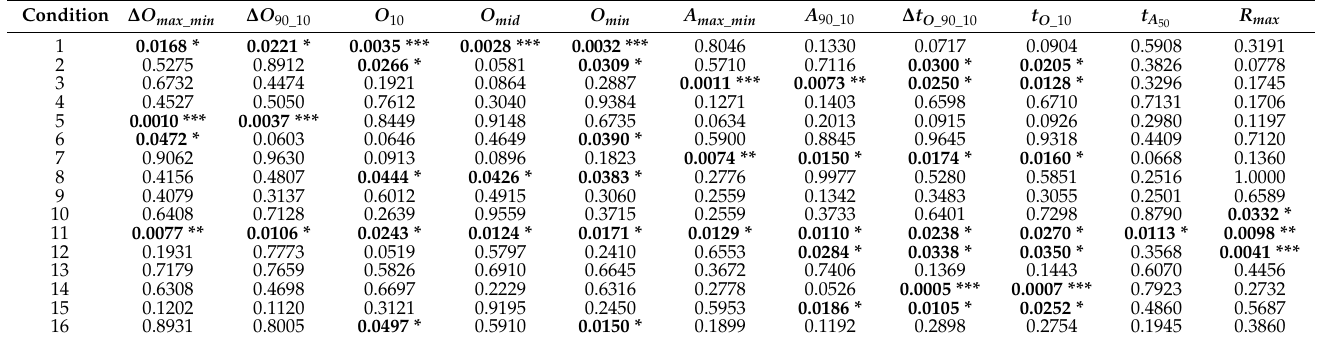
Table 3. Global aptitude indicator for each experimental condition and each